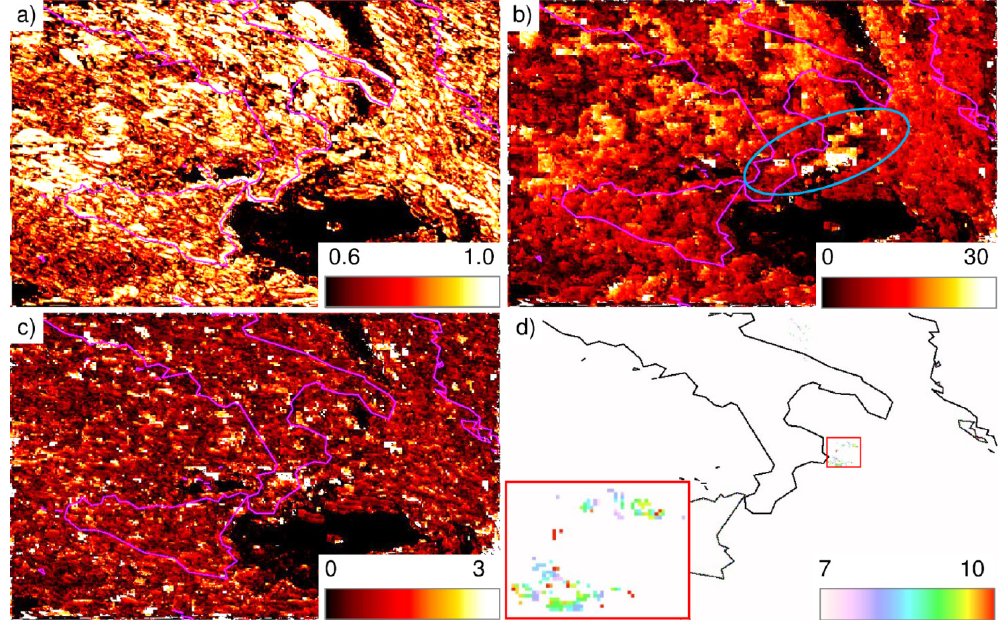
Figure 7. ( a ) Correlation; ( b ) parallax shift (in km); ( c ) distance between intersecting lines